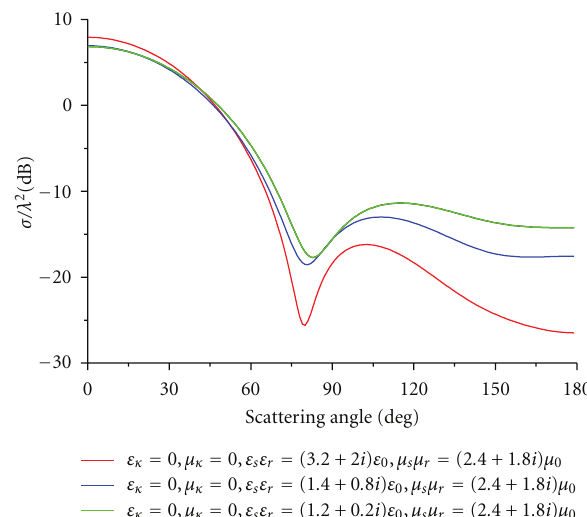
Figure 3: Normalized Radar Cross Section (RCS) values versus the scattering angle. Here the permeability and the permittivity are complex number. The Loss gyrotropic influence is considered. Here k 0 r = 0 . 75 π